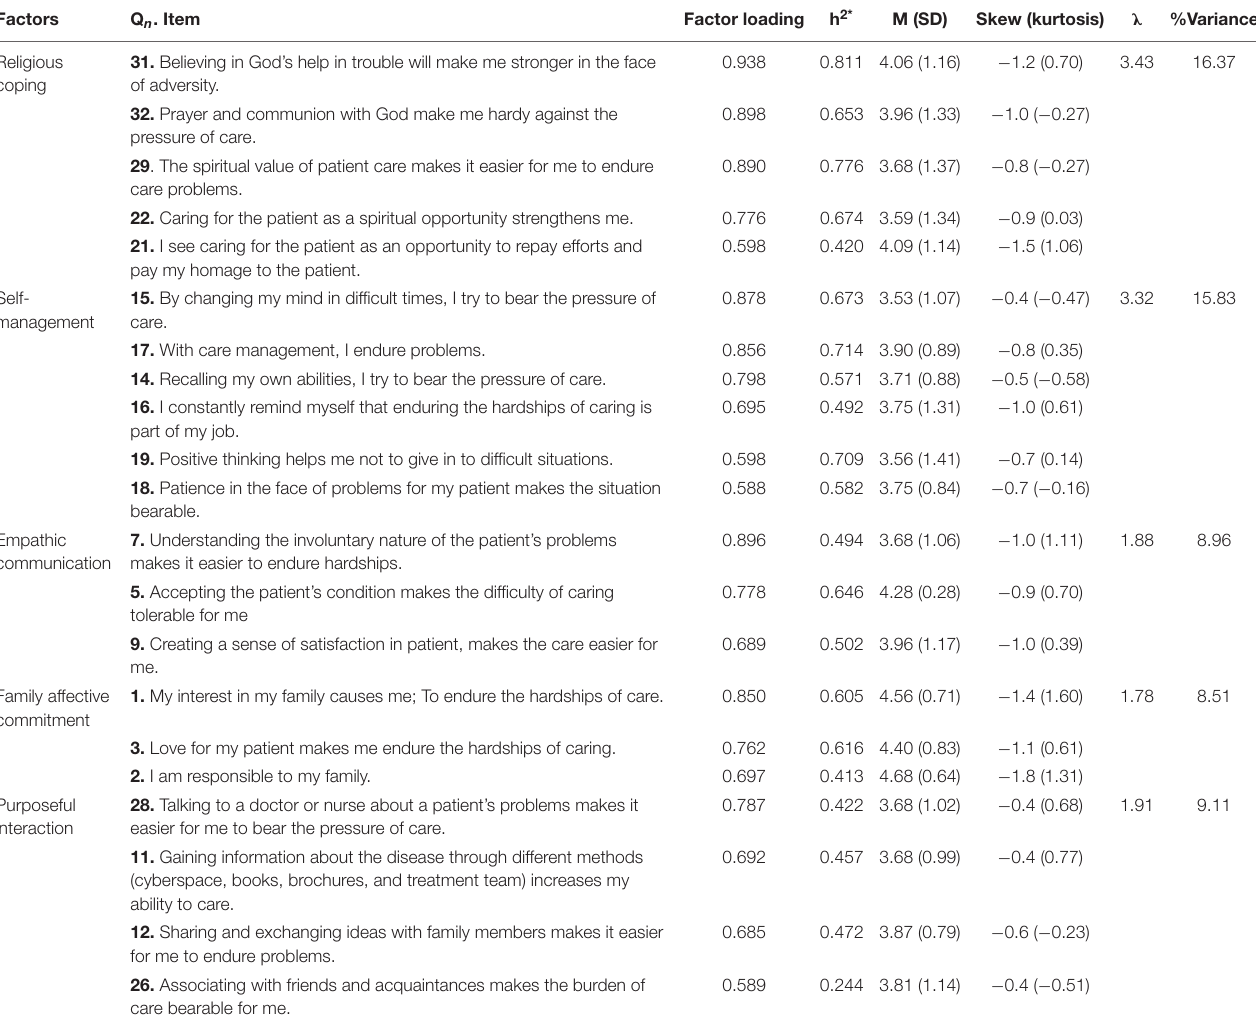
TABLE 2 | The result of EFA on the five factors of FCHS ( N = 210). Factors Q n . Item